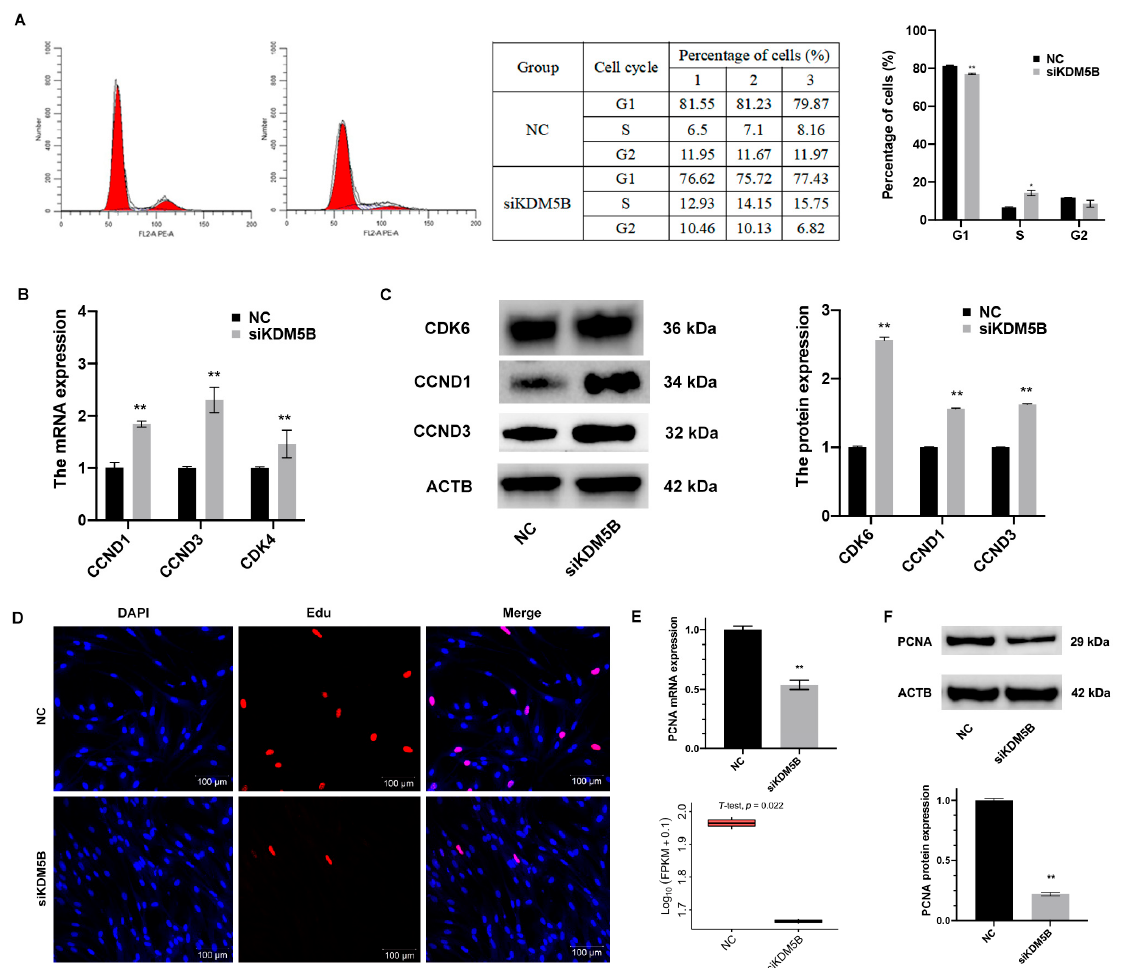
Figure 3. Blocked S phase and restrained proliferation in KDM5B knockdown GCs. ( A ) Flow cytometry results show that the percentage of cells in the G1 phase significantly decreases in the KDM5B knockdown goat GCs and the percentage of cells in the S phase increases compared to the NC. Red represents cells in G1 and G2 phases. ( B ) mRNA expressions of Ccnd1, Ccnd3 and CDK4 increase in the KDM5B knockdown goat GCs compared to the NC, as determined by qPCR. ( C ) Western blot shows that CDK6, Ccnd1 and Ccnd3 protein levels increase in the KDM5B knockdown goat GCs compared to the NC. ( D ) Goat GCs treated with siKDM5B show decreased Edu incorporation relative to the NC. Hoechst indicates nuclear staining. The scale bars correspond to 100 µ m. ( E ) mRNA expression of PCNA significantly decreases in the KDM5B knockdown goat GCs relative to the NC. ( F ) Western blot shows that PCNA protein level significantly decreases in the KDM5B knockdown goat GCs relative to the NC. ** means p < 0.01, * means 0.01 < p <